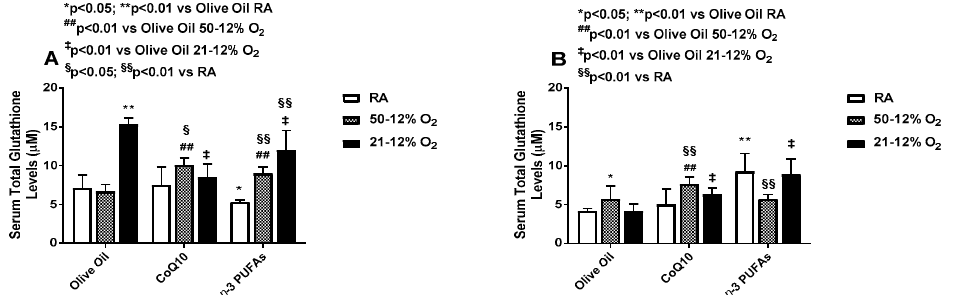
Figure 8. Effects of neonatal IH with Co-Q10 or n -3 PUFA supplementation on serum total glutathione levels. Panel ( A ) represents treatment during IH exposure and supplementation for 14 days, and panel ( B ) represents recovery from IH (IHR) in room air (RA) with no treatment. Groups are as described in Figure 2. Data are expressed as mean ± SD ( n = 8 samples/group).